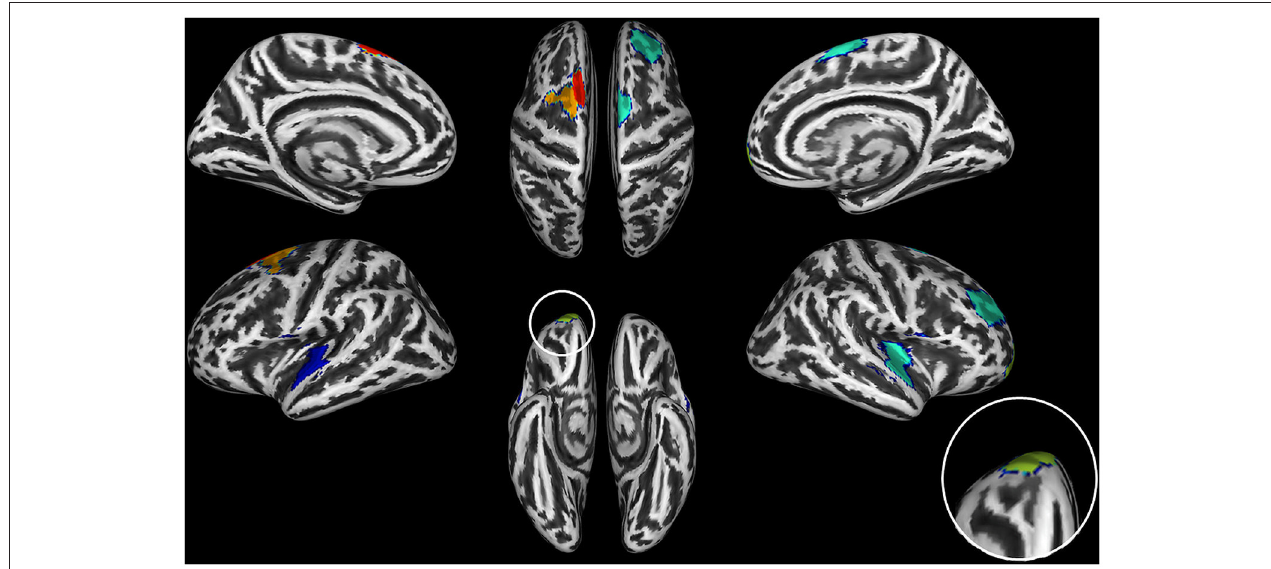
FIGURE 4 | Brain regions with significant thinning in both AUD and OUD individuals when compared to controls. The seven shared brain ROIs showing significantly reduced cortical thickness in both alcohol use disorder (AUD) and opioid use disorder (OUD) individuals when compared with controls. Dark blue, Somatosensory Network; green, Salience/VentralAttention Network; light green, Limbic Network; orange, Executive Control Network; red, Default Mode Network. The inset on the right side of the figure shows an increase of the orbitofrontal cortex ROI, the region with the most significant thinning in all three substance use disorder (SUD)